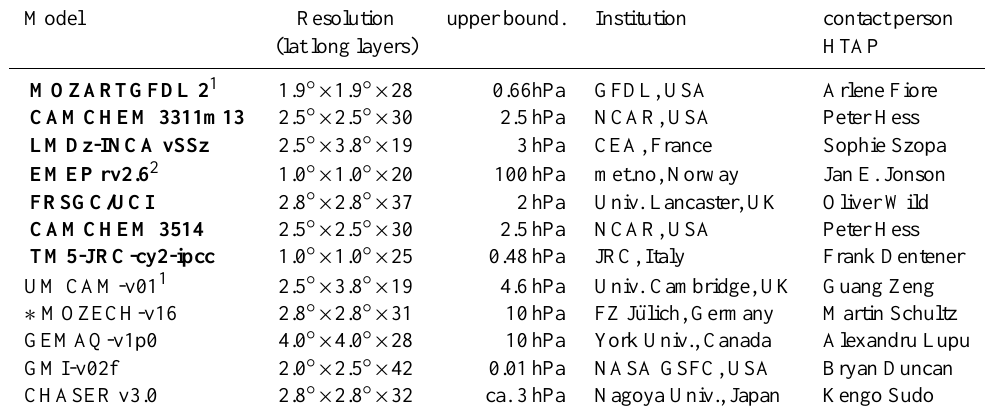
Table 1. Models providing vertical profiles of ozone for the TF HTAP intercomparison. Documentation of the models can be found at http://www.htap.org/ under the heading: Model Descriptions. Only the 7 first models (in bold) provided vertical profiles for the SR20%